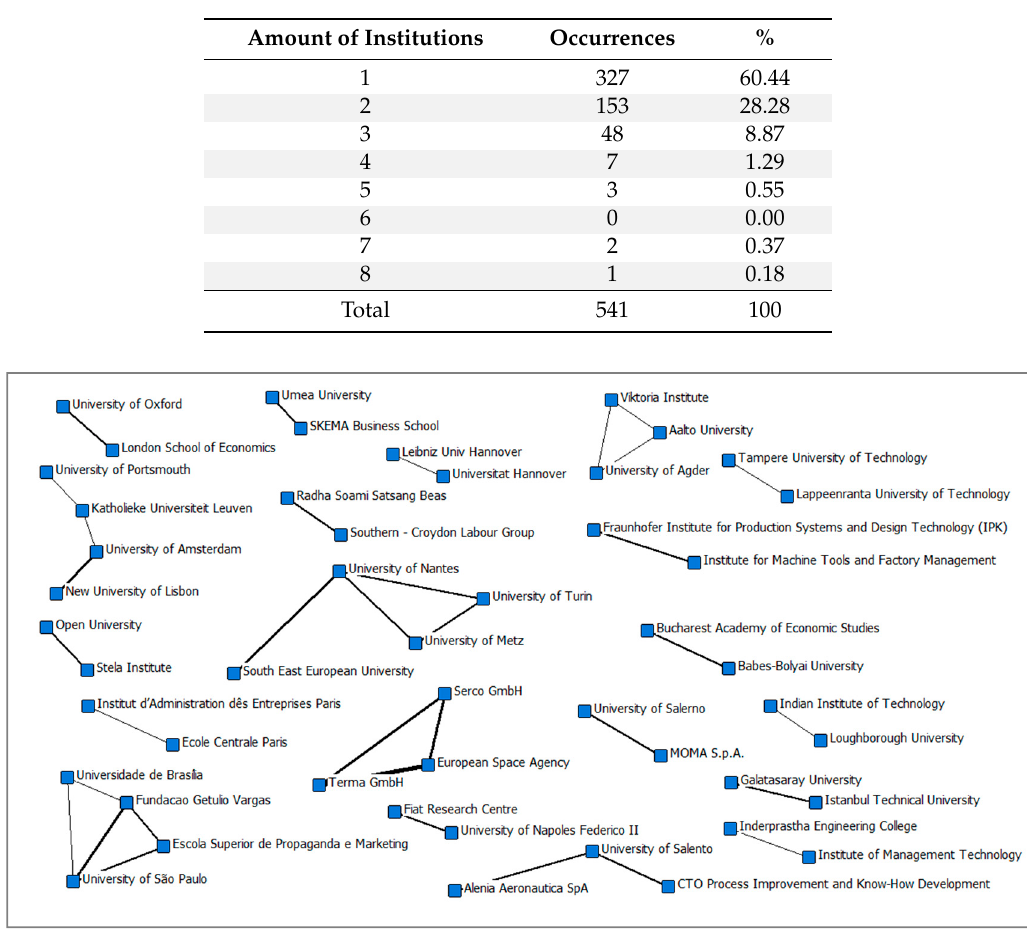
Figure 4. Interinstitutional collaboration in studies related to competence-based management.